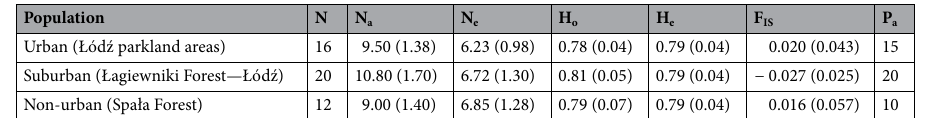
Table 3. Summarized statistic of genetic descriptors for blue tits populations including number of individuals (N) per population, number of alleles (N a ), number of effective alleles (N e ), heterozygosity indices (H o and H e ), inbreeding coefficient (F IS ) and number of private alleles (P a ). Mean values with standard errors provided in parentheses were calculated for 10 microsatellite loci. Urban, suburban and non-urban populations are represented by individuals sampled in Łódź parkland areas, Łagiewniki Forest, and Spała Forest, respectively.